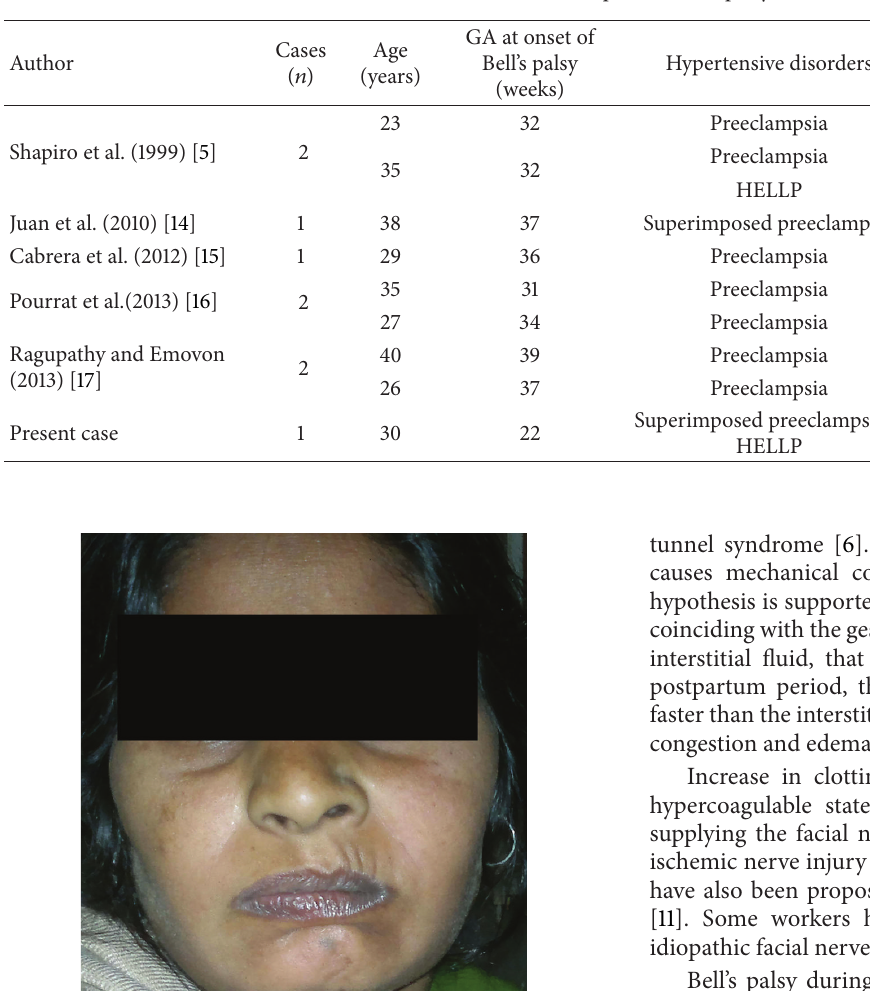
Table 1: Antepartum Bell’s palsy.